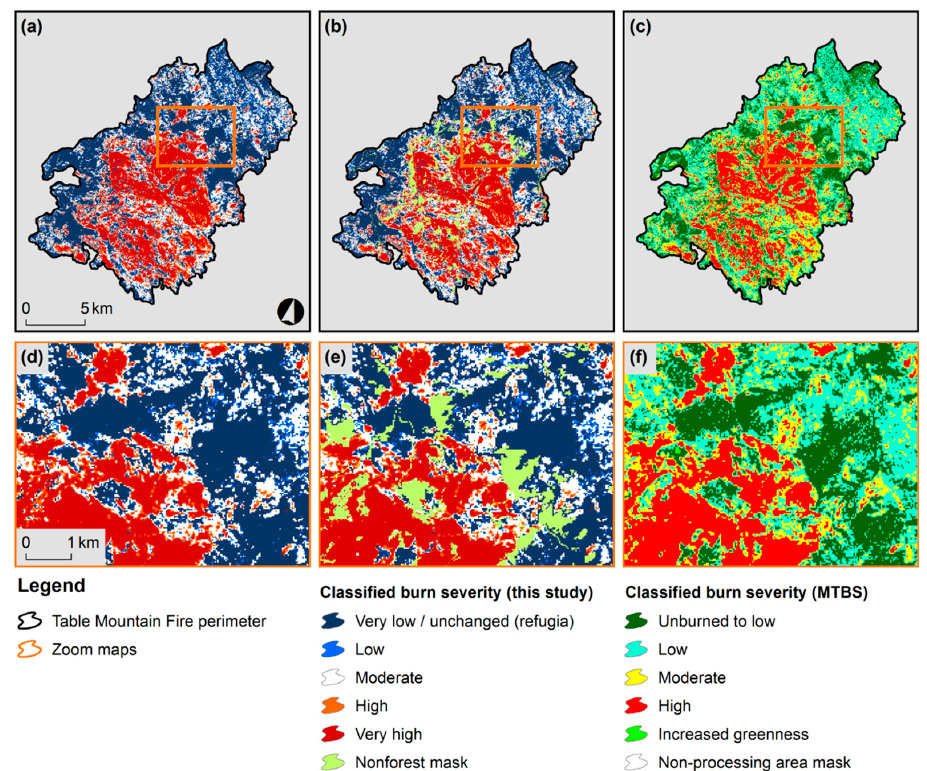
Figure 3. Spatial patterns of burn severity mosaic, refugia, and non-forest areas across the 2012 Table Mountain Complex. Fire location is indicated in Figure 1. Burn severity classes in this study ( a , b , d , e ) are based on Landsat time series, RdNBR, and field-based tree mortality estimates (see Section 2). MTBS severity classes ( c , f ) are based on dNBR protocols described by Eidenshink et al. [35] and exhibit similar spatial patterns, particularly the lowest- and highest-severity classes. According to our severity maps, non-forest conditions (non-forest mask) accounted for 31% of refugia extent across all fires and 10% of refugia extent across the Table Mountain Complex. Zoom maps ( d – f ) show how non-forest conditions are more prevalent in some refugia areas. MTBS: Monitoring Trends in Burn Severity;